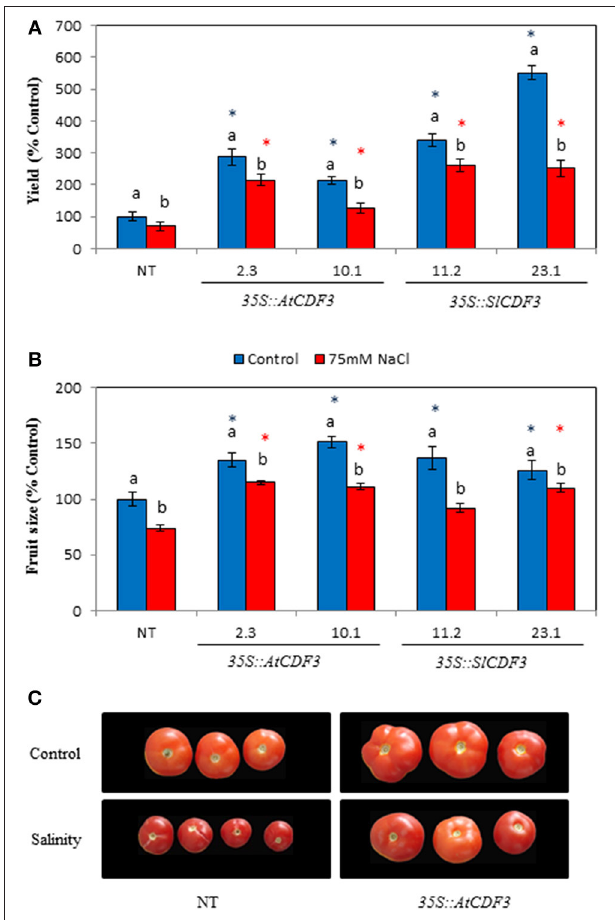
FIGURE 5 | Agronomic performance of tomato plants overexpressing AtCDF3 or SlCDF3 genes under control and salinity conditions. (A) Yield and (B) fruit size of tomato plants under control (blue bars) and salinity (75 mM NaCl; red bars) conditions. Plants were cultured in the greenhouse from December to mid-August. All fruits were harvested at maturity in each plant until the 6th truss. The results are provided as a percentage of yield or fruit size in relation to the NT plants grown under the control conditions. (C) Representative examples of the tomatoes from the NT or 35S::AtCDF3 (line 2.3) plants grown under control or salt stress. Asterisks indicate significant differences ( P < 0.05) with the NT plants grown under the same condition. Letters indicate significant differences for a given genotype between the control and salinity conditions. NT, non-transformed.